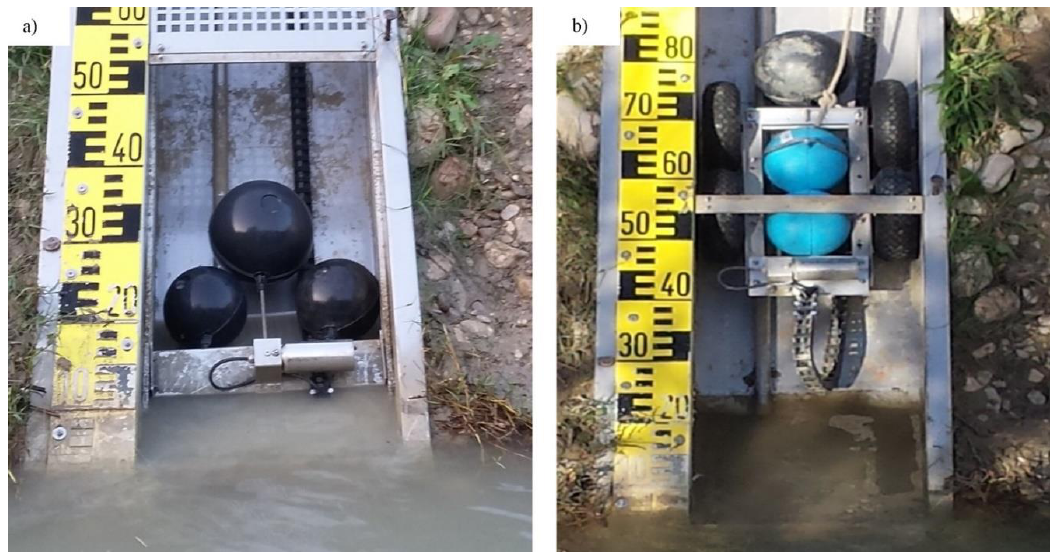
Figure 8. Initial flotation system ( a ) and modified flotation system ( b ).